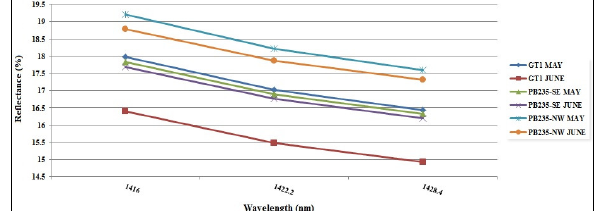
Figure 16. Spectral behaviour in leaf scale in the region 1,420nm of the Rubber trees stands: GT1, PB235-SE and PB235-NW